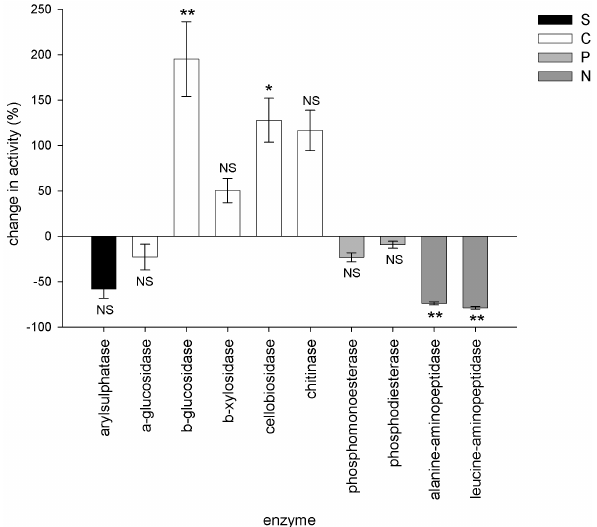
Fig. 5. Effect of pH on the enzyme activities. Increase (positive val- ues) or decrease (negative values) (%) of the activity with decreased pH (activity at pH 4 compared to that at pH 5.5). Data are pre- sented as averages ± standard error of mean; n = 16. ∗∗ p ≤ 0 . 002; ∗ p ≤ 0 . 05; NS nonsignificant. C, C-acquiring enzymes; N, N- acquiring enzymes; P, P-acquiring enzymes; S, S-acquiring en-